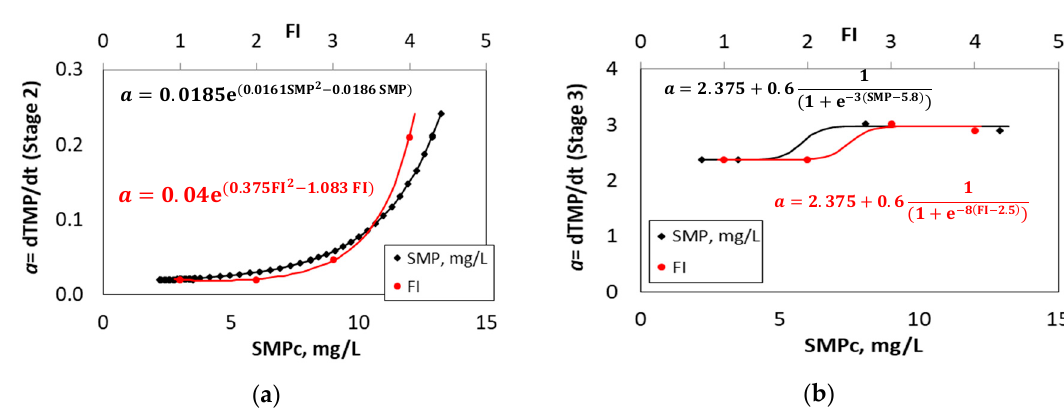
Figure 9. Correlation of dTMP/dt with FI and SMP c concentration for: ( a ) Stage 2 (long-term fouling) and ( b ) Stage 3 (TMP jump).